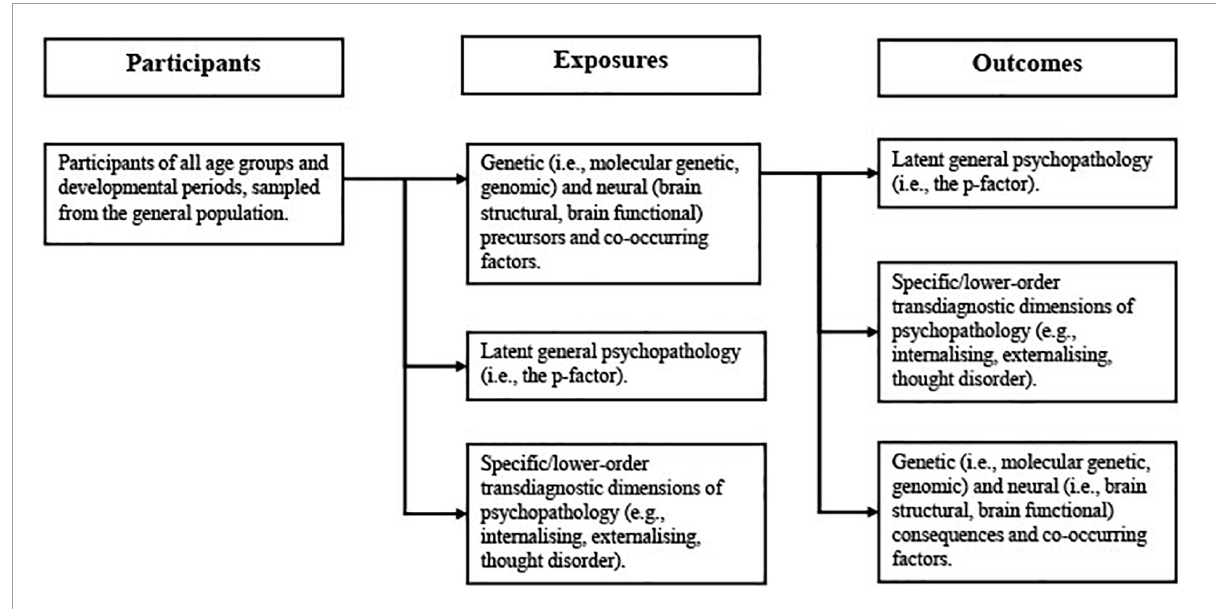
FIGURE1 Exposure/outcome relationships that will be examined in the upcoming